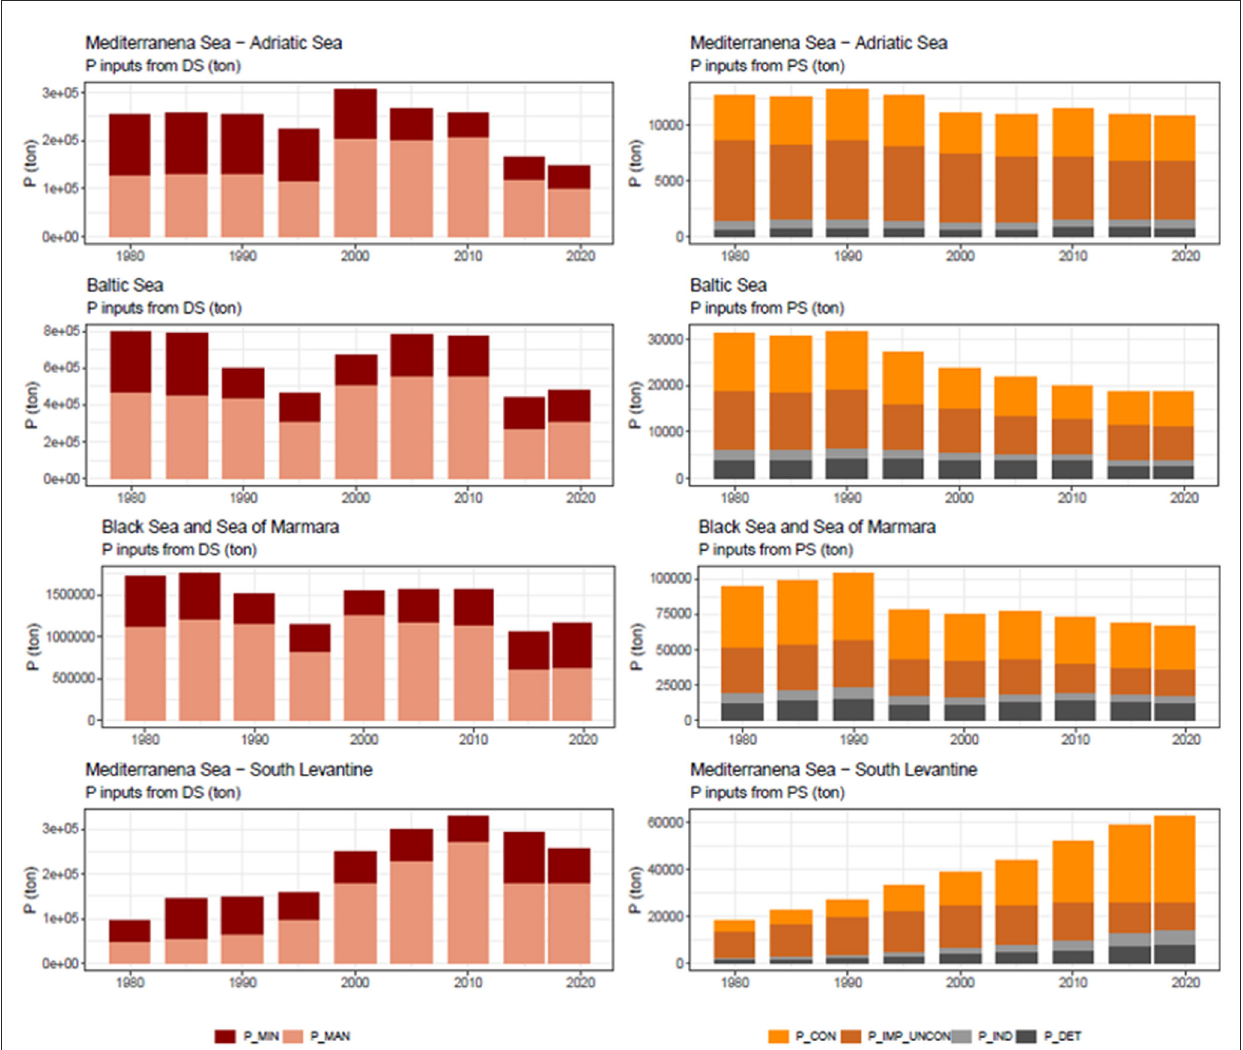
FIGURE5 Phosphorus inputs (ton) by selected marine regions in the study area. On the left , diffuse sources: P_MIN P mineral fertilizer and P_MAN P manure; on the right , point sources: P_CON P emissions collected in sewerage systems; P_IMP_UNCON P emissions from other systems that are disconnected from sewerage systems; P_IND P contribution from industrial discharges; and P_DET P emissions from